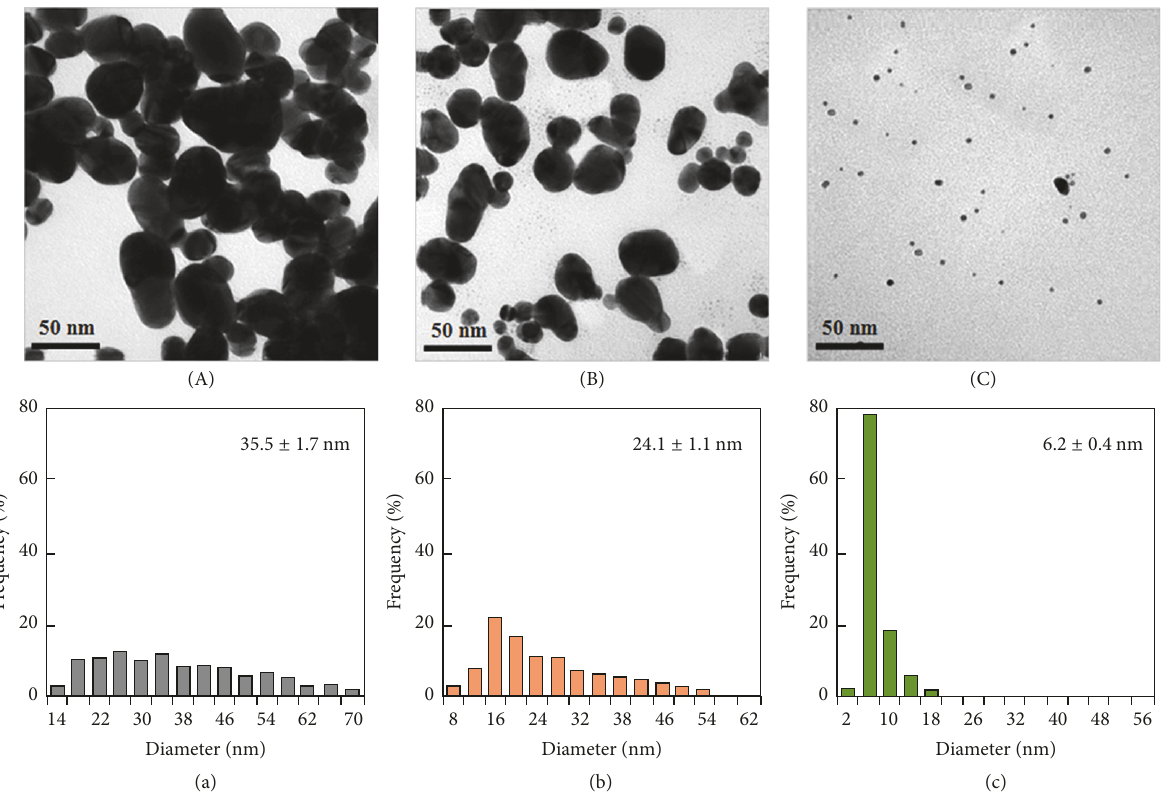
Figure 2: TEM images and size distribution histograms of AuNPs/dextran at different pH: 5.5 (A, a), 6.5 (B, b), and 7.5 (C, c).